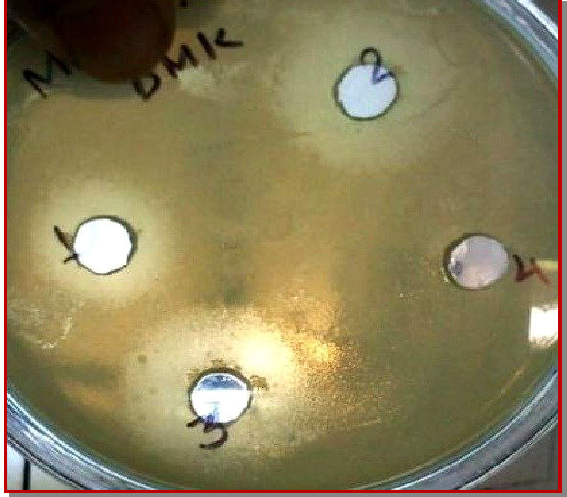
Figure 2: The plate shows zone of clearance where 1 repre- sents Bacillus sp SFN crude in production media without shrimp shell, 2 and 3 represent Bacillus sp SFN crude in pro- duction media with shrimp shell and 4 as